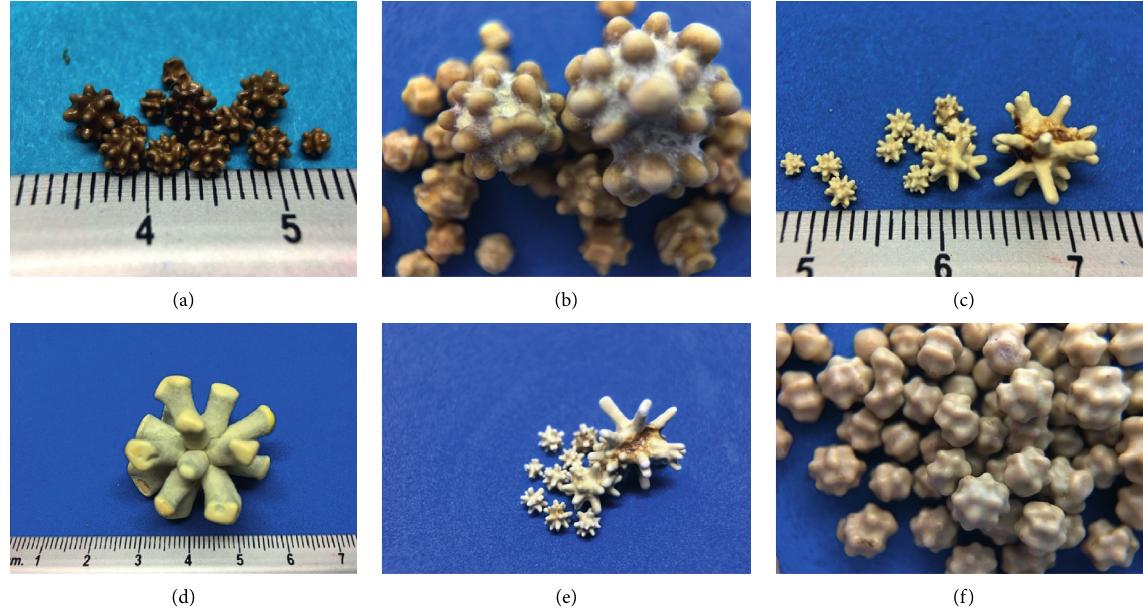
Figure 2: Pure silica uroliths extracted from the lower urinary tract of different dogs. Despite the differences in size, shape, and color of the uroliths, no variations in their chemical composition were